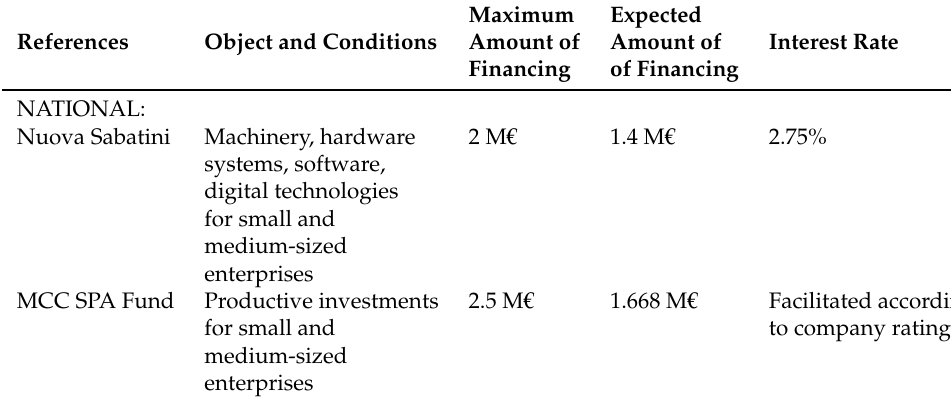
Table 26. Sources of